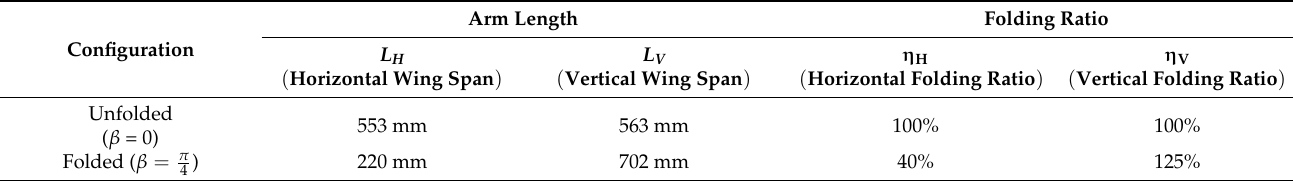
Table 2. The comparison of folding ratio for folded and unfolded